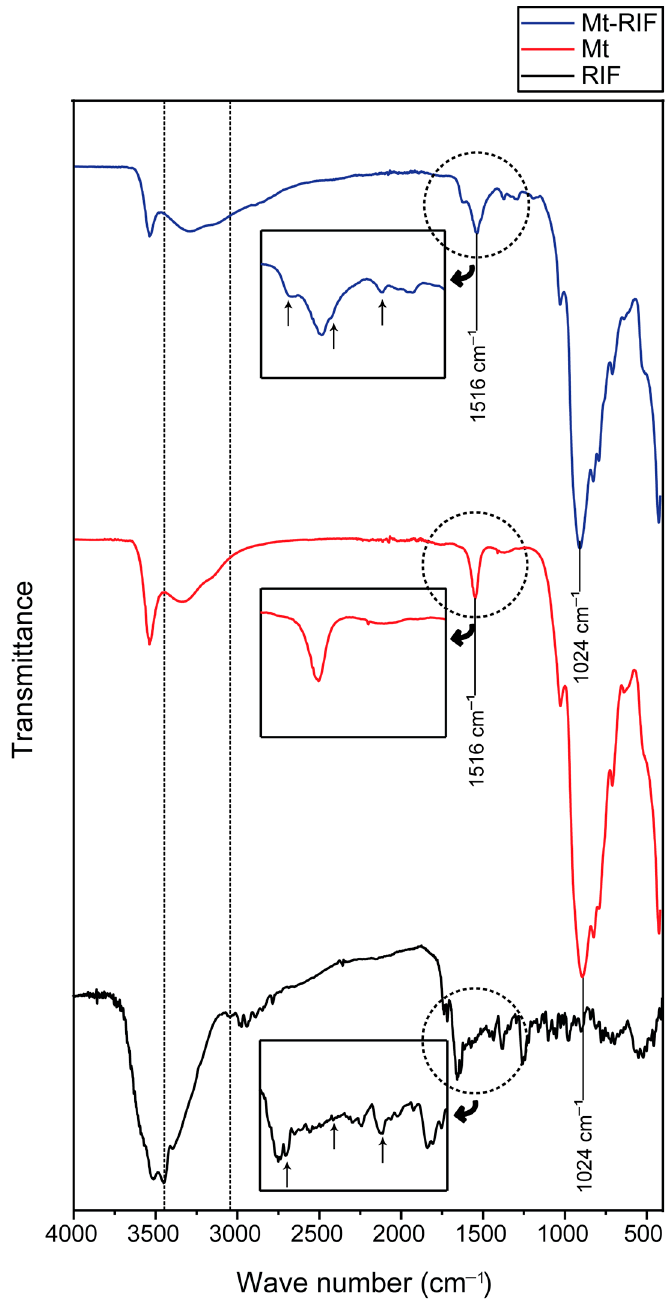
Figure 5. FTIR spectra for RIF (in black), Mt (in red) and Mt–RIF hybrid (in blue).